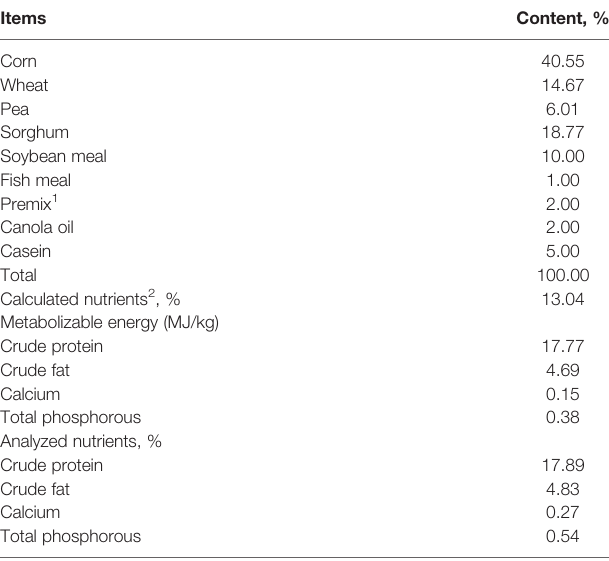
TABLE 1 | Ingredient composition and nutrient levels of the arti fi cial crop milk. Items Content, % Corn